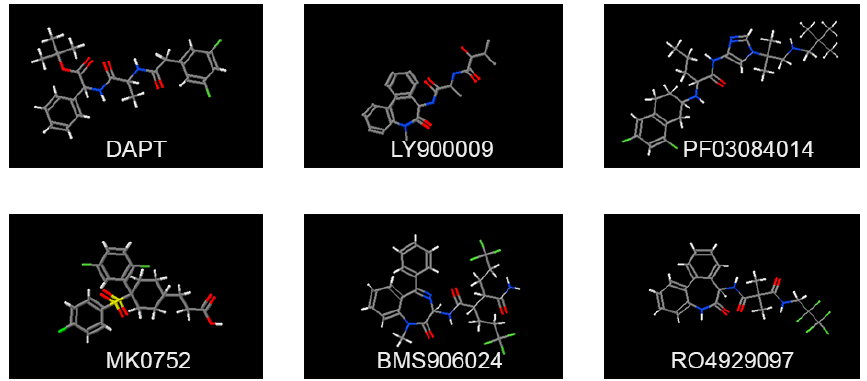
Figure 2. GSI structures. Structures of some commonly used GSI, which are used in vitro and in clinical trials.